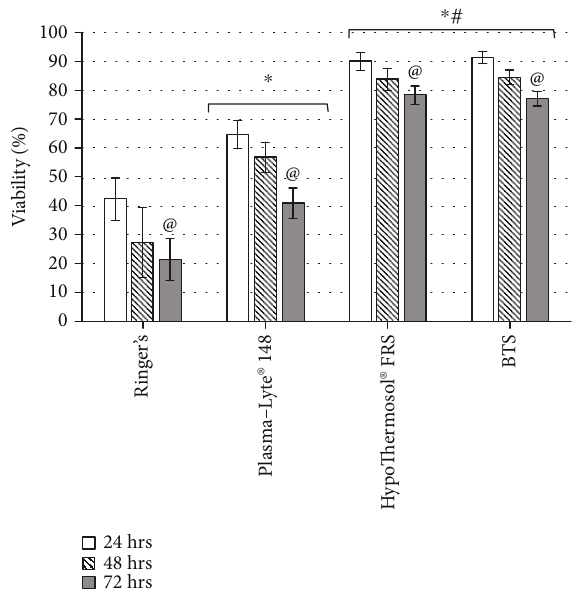
Figure 1: Viability of MSCs after hypothermic storage in di ff erent solutions during 24hrs, 48 hrs, and 72hrs, determined by Trypan Blue staining. ∗ Values are signi fi cantly higher compared to Ringer ’ s solution ( p < 0 05 ); # values are signi fi cantly higher compared to Plasma-Lyte® 148 solution ( p < 0 05 ); @ values are signi fi cantly di ff erent compared to the same group after 24hrs of storage ( p < 0 05